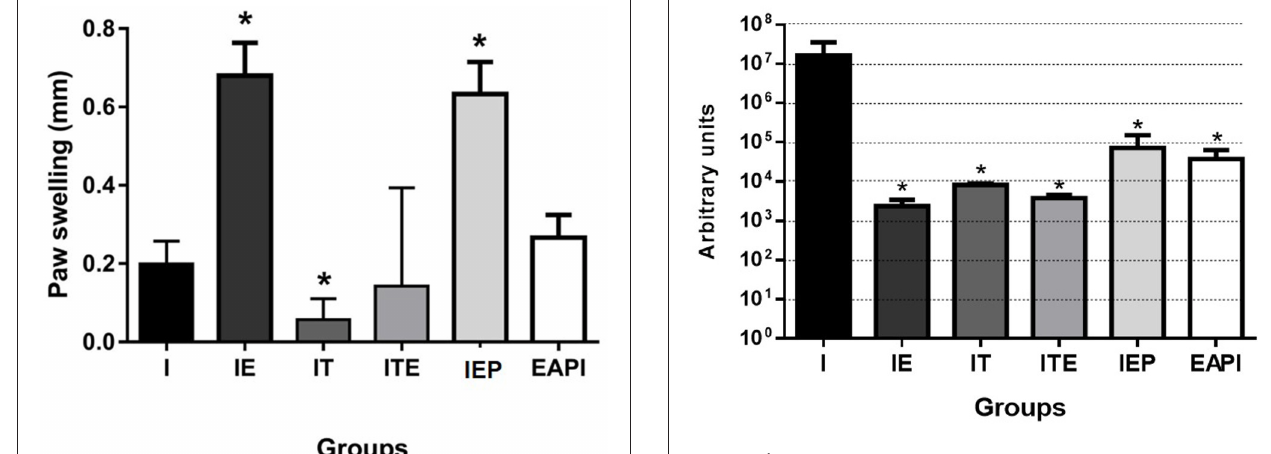
FIGURE 4 | Parasitic burden of infected mice. Parasites were isolated from the paws after 13 weeks of infection and quantified by serial dilution in Schneider’s medium plus 20% FBS. After isolation, they were kept at 26 ◦ C until the presence of parasites was observed in group I (7th day). Then, the parasites were quantified in Neubauer Chamber, and the number of parasites obtained was divided by the total weight (gram) of infected paws tissue. Values are expressed as the mean of two experiments with the samples of eight animals per group grouped as a pool. The bars represent the standard error of the mean. I—Infected. IT—Animals infected and treated with a therapeutic dose (8mg) of Glucantime ® , after the onset of the lesion. ITE—Animals infected, trained and treated with therapeutic dose (8mg) of Glucantime ® after the onset of injury. IE—Animals infected and trained from the first week of infection. IEP—Animals infected and trained after the appearance of the lesion (6th week). EAPI—Animals trained for 6 weeks, infected and trained for another 12 weeks. * P < 0.05 with respect to